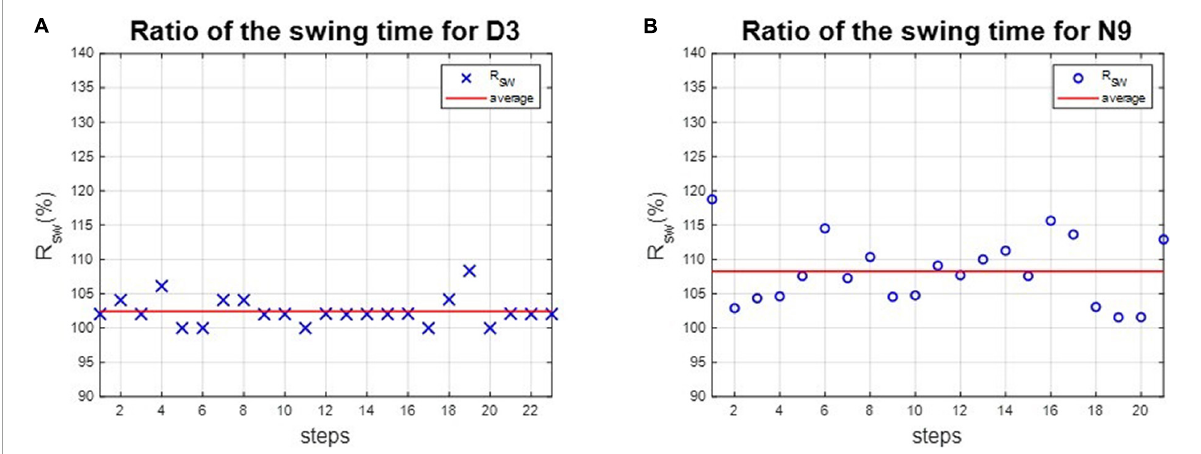
FIGURE6 The ratio of swing time of D3 and N9. The dancer tended to have better R SW than the non-dance control, because of dance training. (A) The dancer D3. (B) The non-dancer control